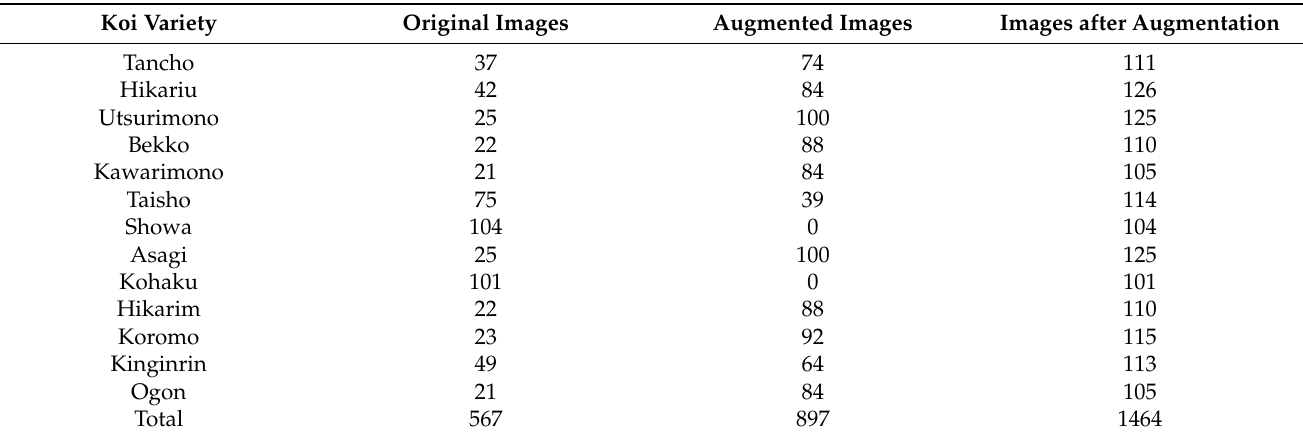
Table 1. Table 1. Numbers of images of thirteen koi Table 1. Numbers of images of thirteen koi varieties.